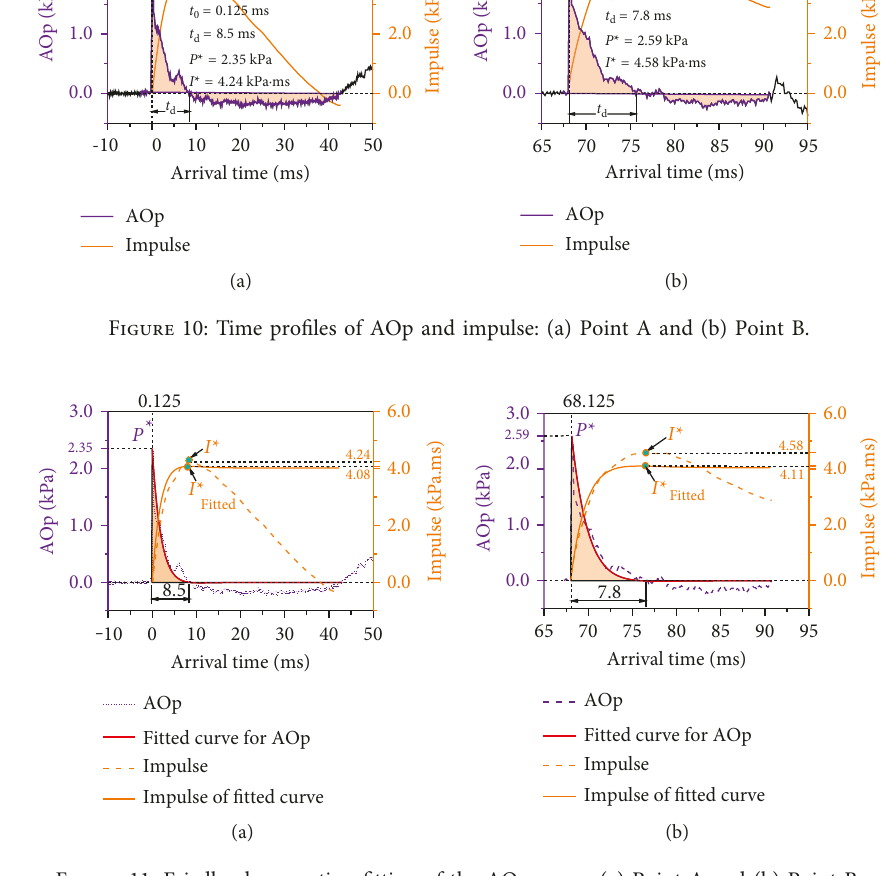
numerical simulation shows that the numerical model with NWBT is still reliable. When the NWBT is operating with a closed wave-blocking curtain, the peak pressure P 79.3%. The energy density decreased from 0.33 kJ to 0.016 kJ, a decrease of more than 90%. The AOp of the explosion was effectively reduced by the NWBT.